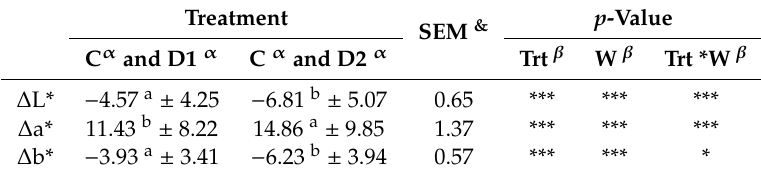
Table 6. Colorimetric interval between the spirulina-supplemented diet and control diet. Treatment SEM &